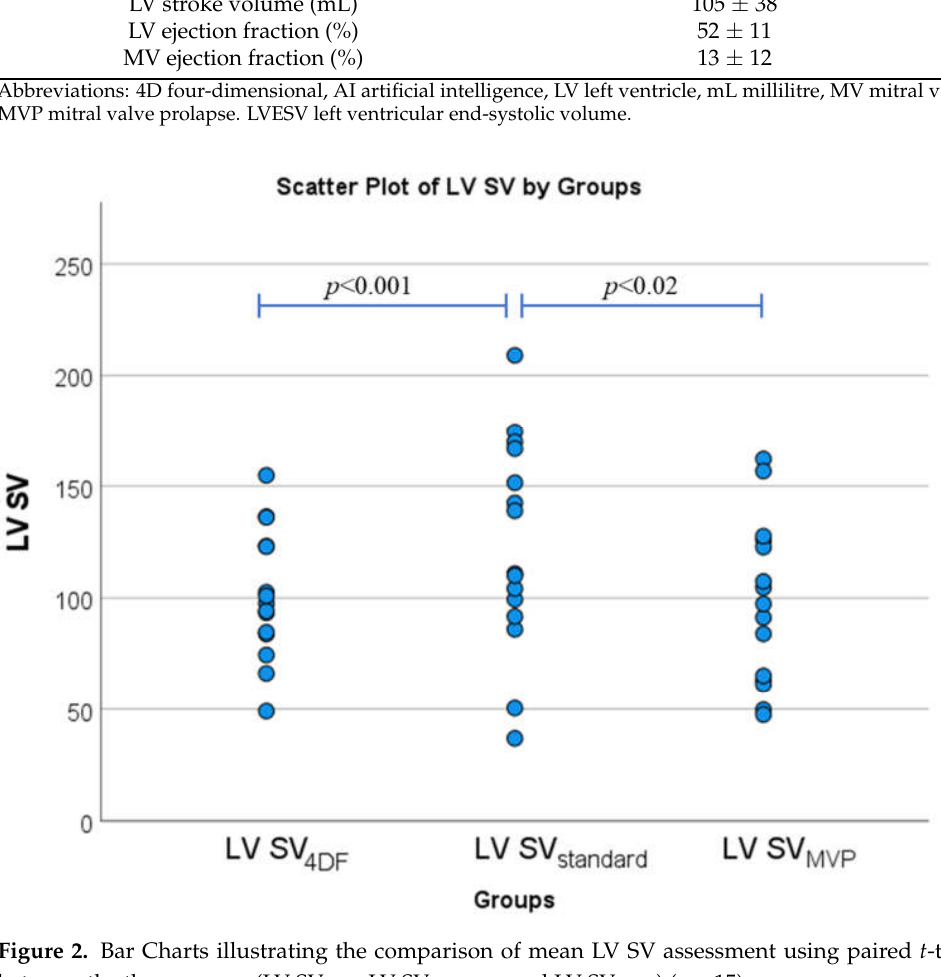
Figure 2. Bar Charts illustrating the comparison of mean LV SV assessment using paired t-tests between the three groups (LV SV 4DF , LV SV standard , and LV SV MVP ) ( n =